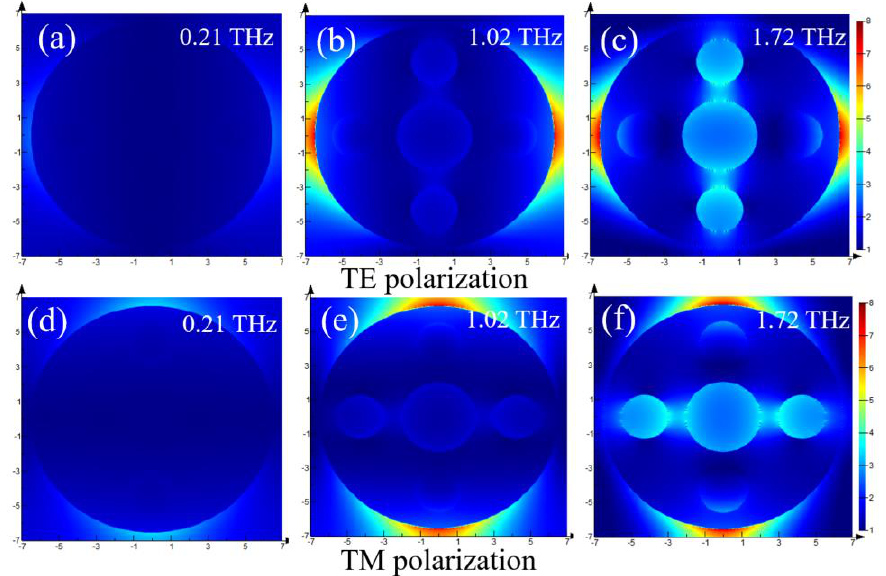
Figure 4. Simulated electric field amplitude ( | E | ) distributions of the proposed absorber, in TE polarization on xy plane at ( a ) 0.21 THz, ( b ) 1.02 THz, ( c ) 1.72 THz; in TM polarization on xy plane at ( d ) 0.21 THz, ( e ) 1.02 THz, ( f ) 1.72 THz.